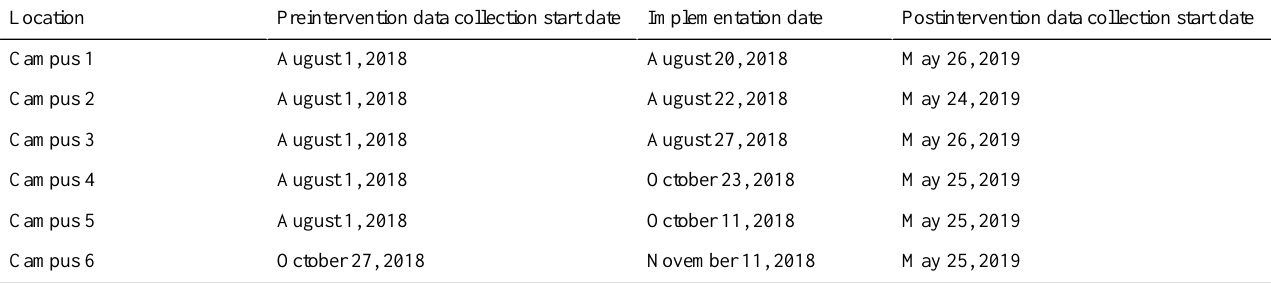
Table 1. Date of iPad education delivery pre- and postintervention by campus